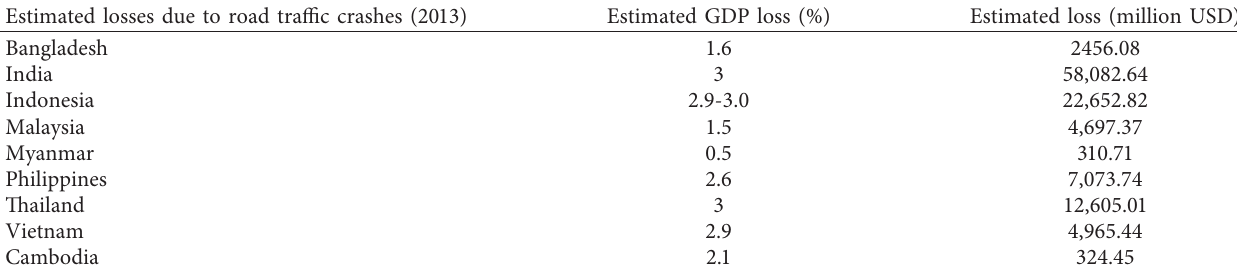
Table 1: Road safety situation in Southeast Asia (source UNESCAP report